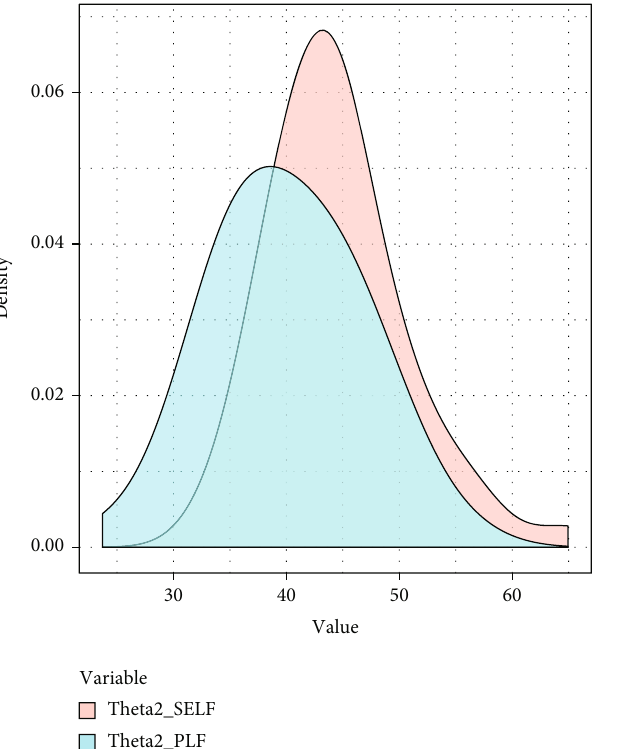
Figure 6: The marginal density for θ